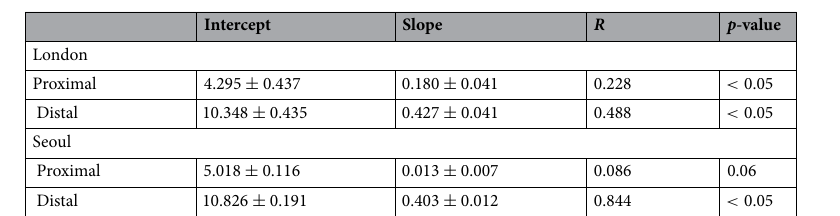
p ˆ µ d i , i from the